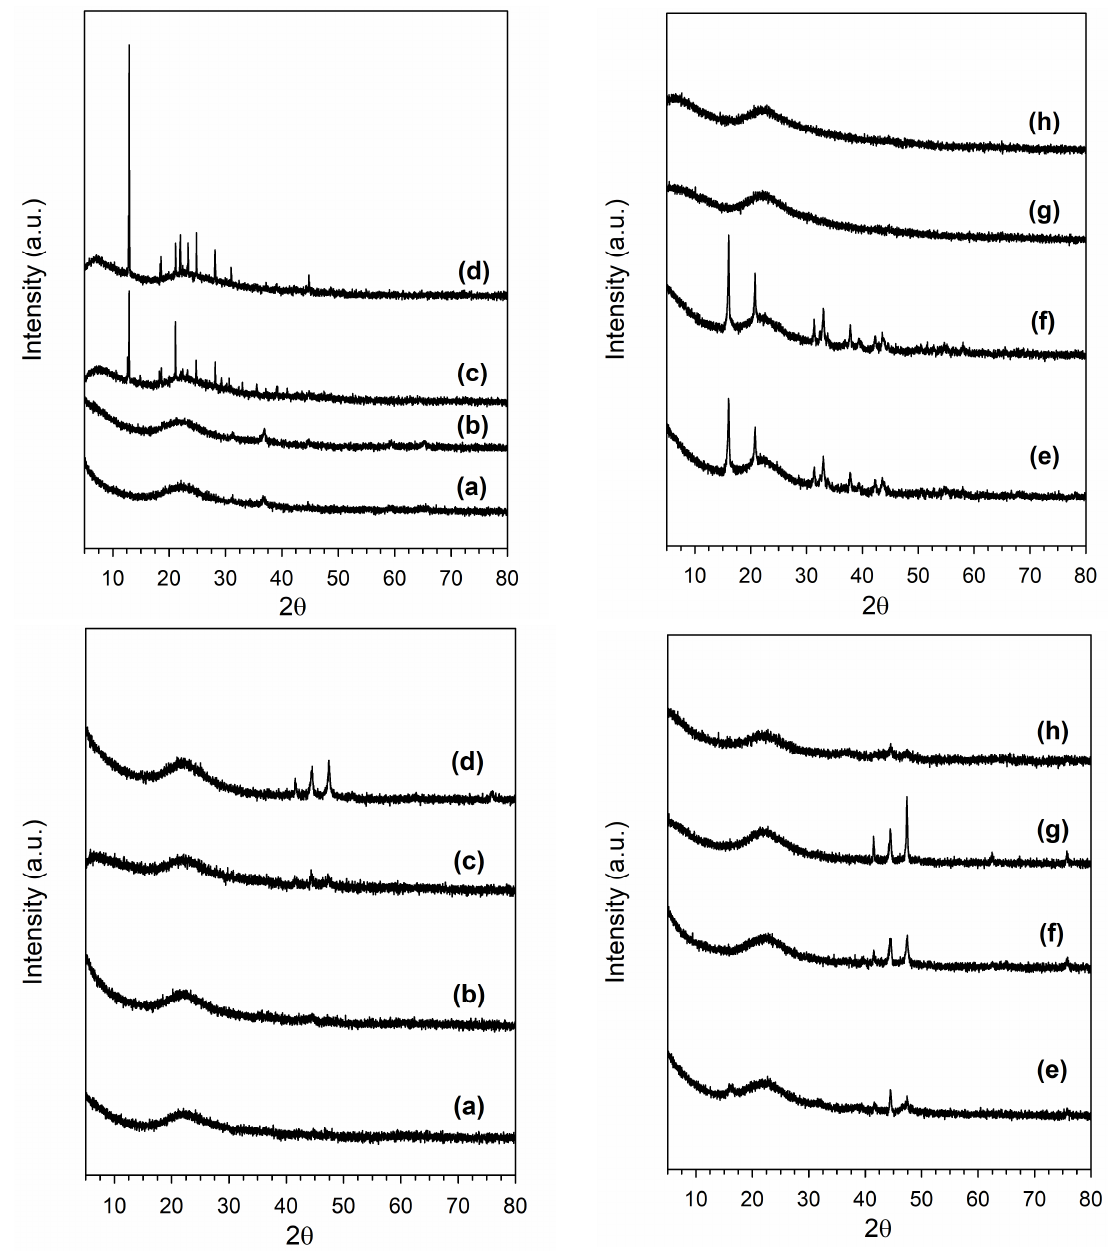
Figure 2. ( top left ) Co acetate precursor, ( top right ) Co chloride precursor, ( bottom left ) Co acetate catalyst after H 2 activation/passivation, ( bottom right ) Co chloride catalyst after H 2 activation/passivation for ( a , e ) air-calcined, ( b , f ) Pt-promoted and air-calcined, ( c , g ) uncalcined, ( d , h ) Pt-promoted, and uncalcined groups.